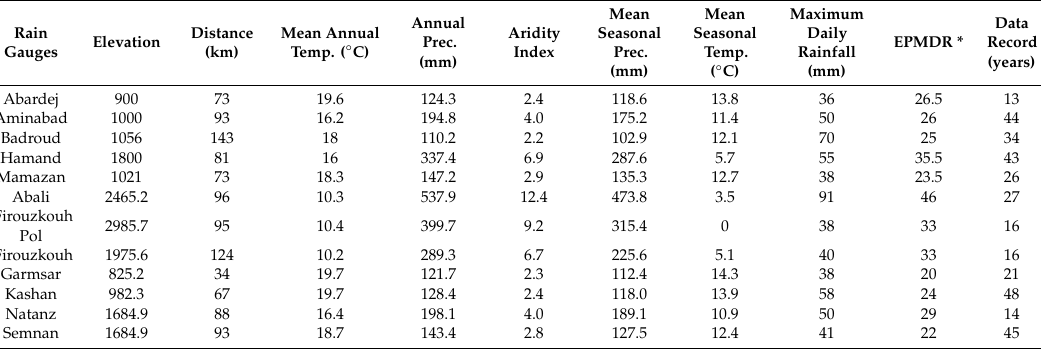
Table 3. Summary of the climatic parameters measured at the selected climatic stations surrounding the Kavir National